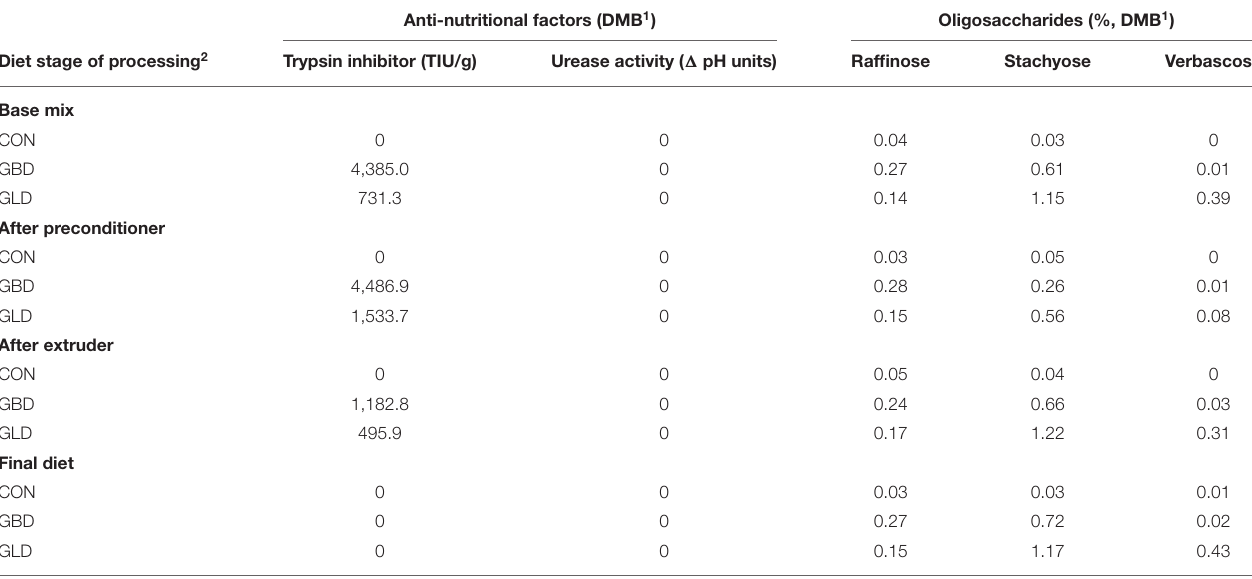
TABLE 4 | Anti-nutritional factors and oligosaccharide content of legume-based canine diets at various processing stages. Anti-nutritional factors (DMB 1